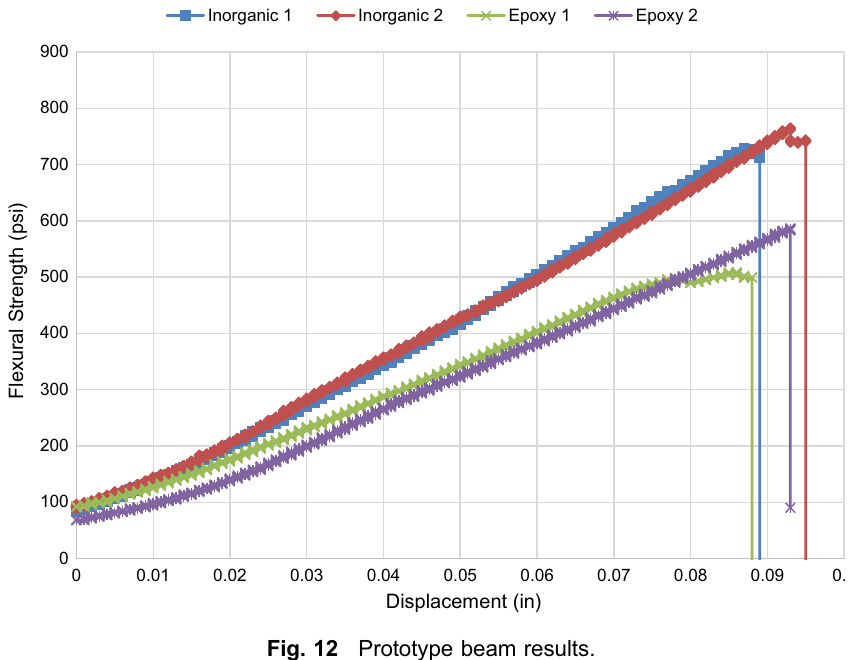
Fig. 12 Prototype beam results.